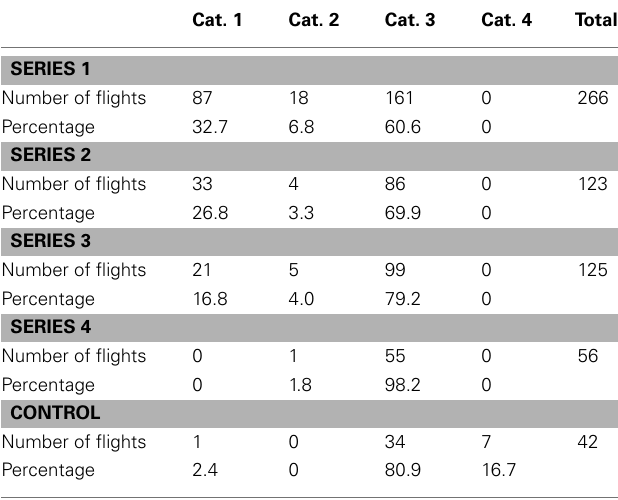
maze. (A) Transfer test setup. (B) Test results. Modified from Zhang et al. (2000). Details in